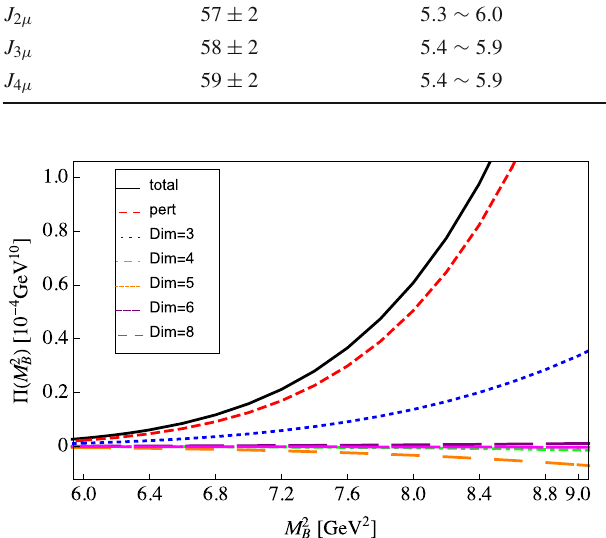
Fig. 3 The OPE behavior for the current η 1 in the J P = 0 + sc ¯ q ¯ b system